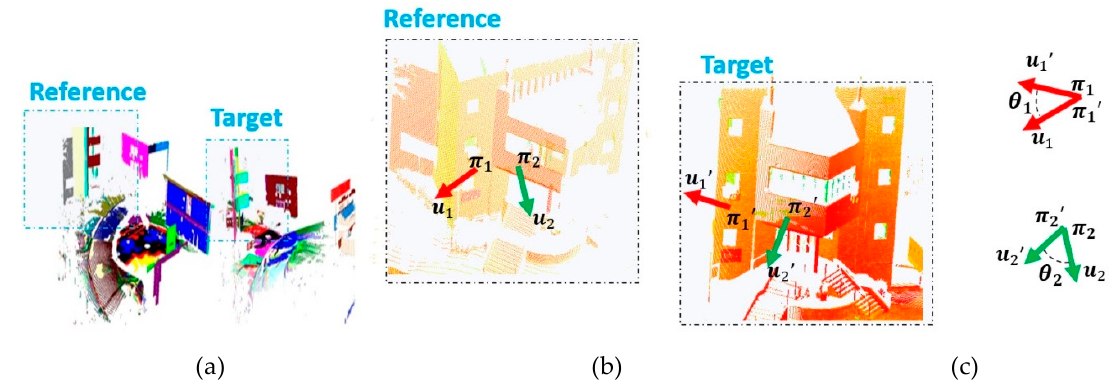
Figure 4. The rotation angle between normal vectors of segmented planes. ( a ) Segmented planes on reference and target point clouds. ( b ) Normal vectors of the planes in both the reference point cloud and the target point cloud. ( c ) Rotation angles for a pair of candidate plane correspondences.